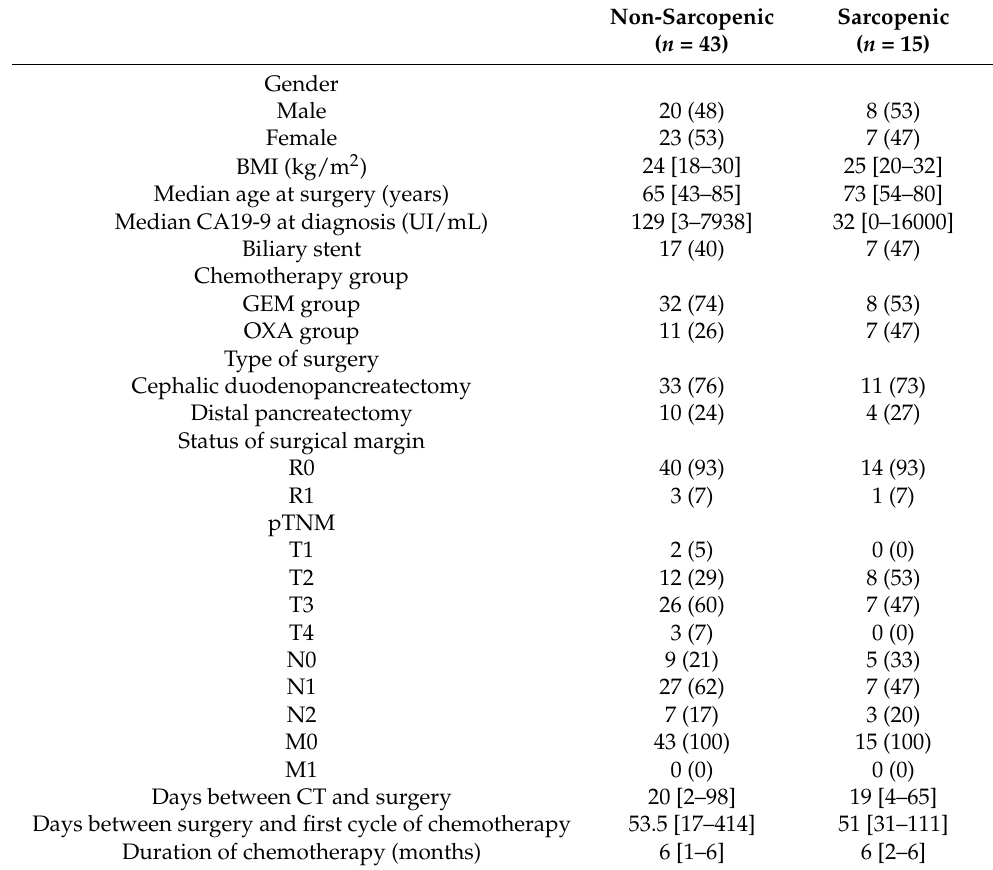
Table 2. Characteristics of the study population according to the sarcopenia